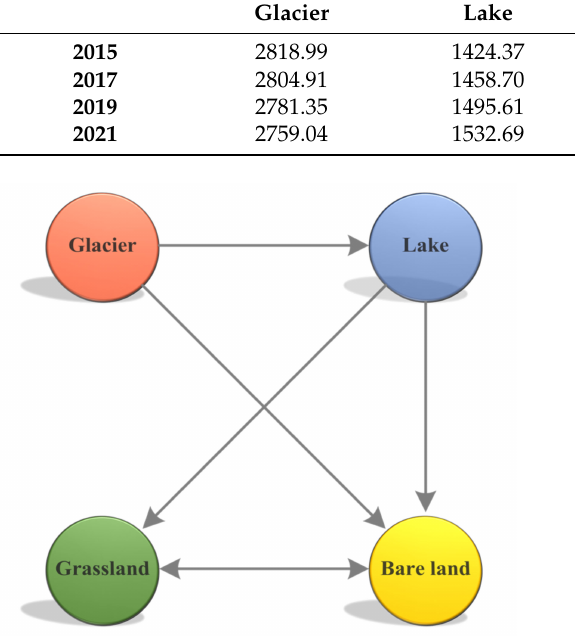
Table 8. The area changes in the different eco-environment elements. Glacier